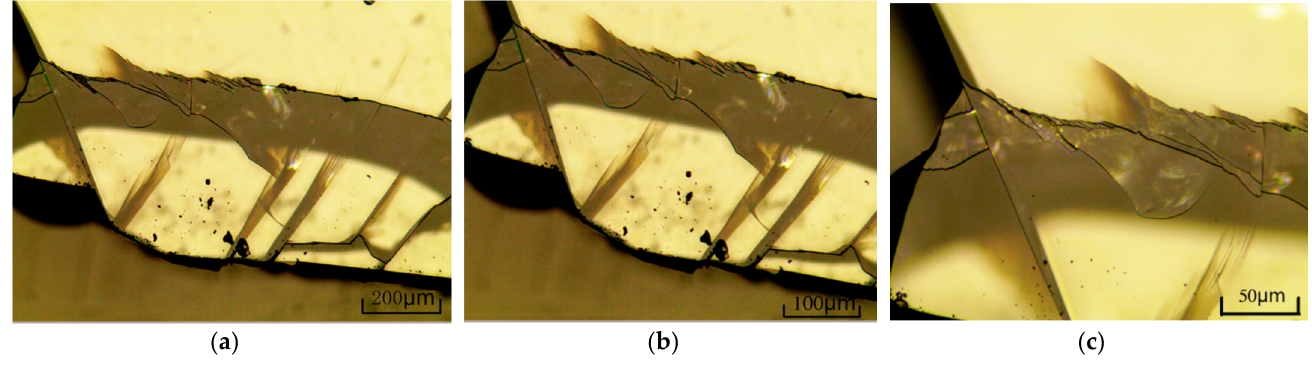
Figure 1. Structure of sapphire material. ( a ) Al 2 O 3 covalent bonding. ( b ) Sapphire crystal structure. ( c ) Cutting surface of sapphire material. ( d ) Cutting schematic diagram.